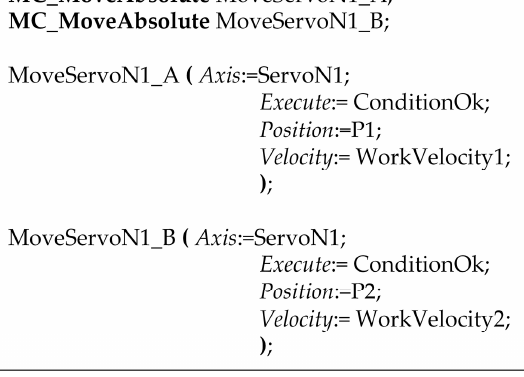
Figure 3. Example of a program to move a servo axis in “structured text” according to the PLCopen standard.